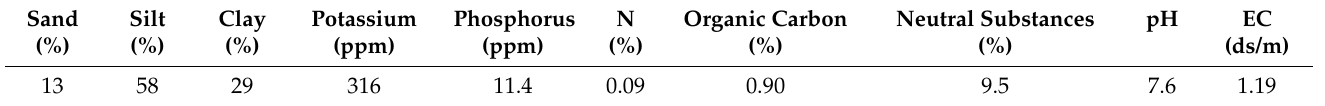
Table 1. Soil physical and chemical properties of the experiment site (0–30 cm